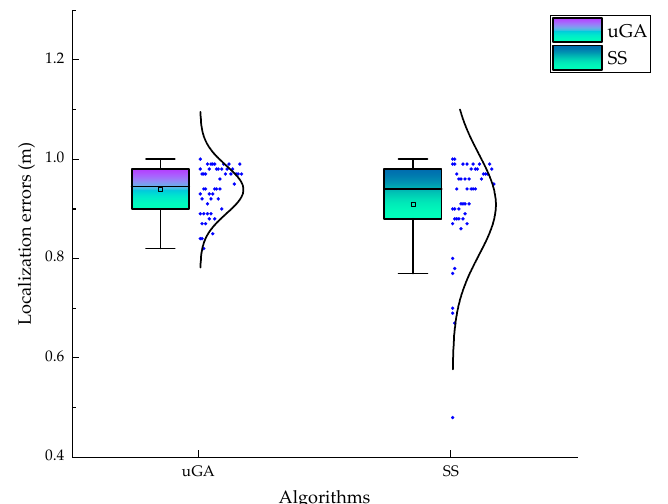
Figure 5. Quantile–quantile (Q–Q) plots of the time cycles spent by uGA and SS. The thin gray lines are the upper and lower percentile lines with a confidence level of 95%. ( a ) Normal Q–Q plot of the time cycles spent by uGA; ( b ) normal Q–Q plot of the time cycles spent by SS.